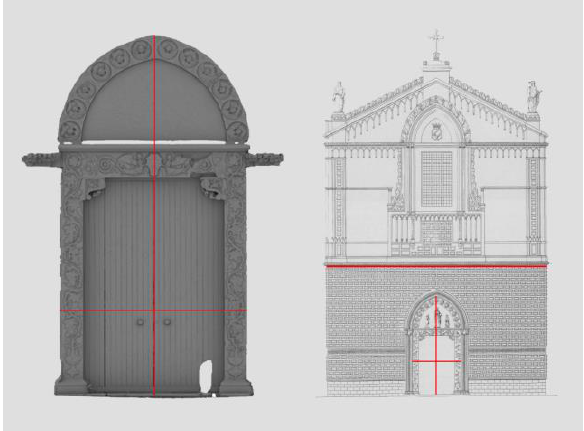
Figure 7 . External orientation reference data. The width of the façade size has been measured, from the center of projection, on the interpretation line through the vanishing point of the horizontal lines of the façade. Two interpretation lines through the endpoints of the image of the segment in the photographic image have been drawn. The so-called ‘parallelogram rule’ allowed to detect the reconstruct the size and position of this segment in 3D (fig.